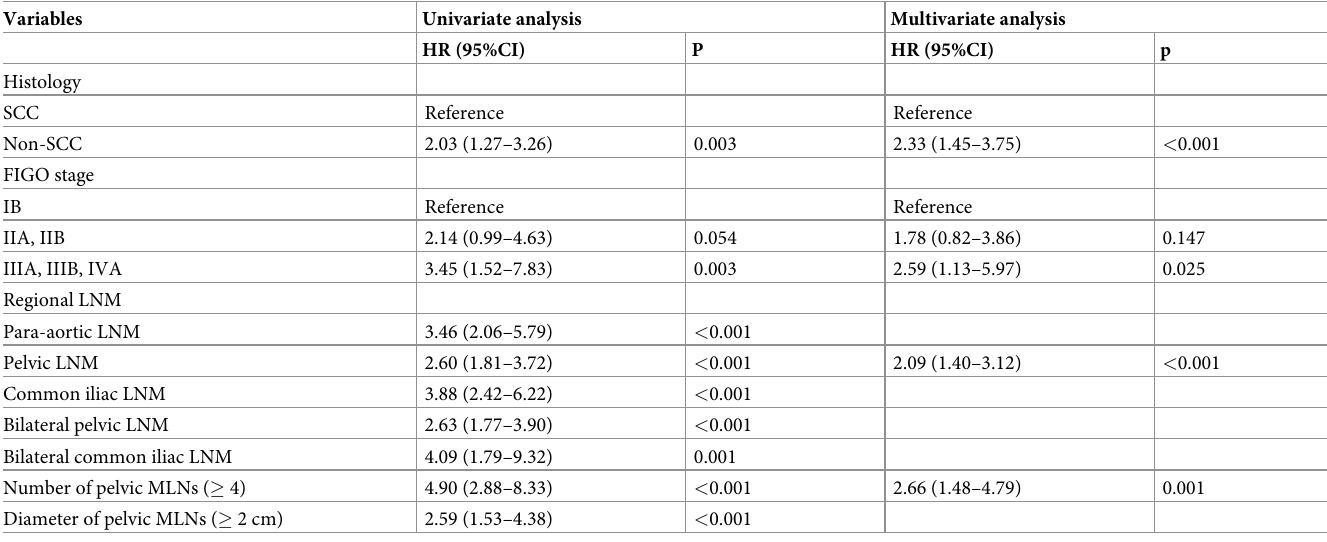
Table 5. Univariate and multivariate analysis for distant